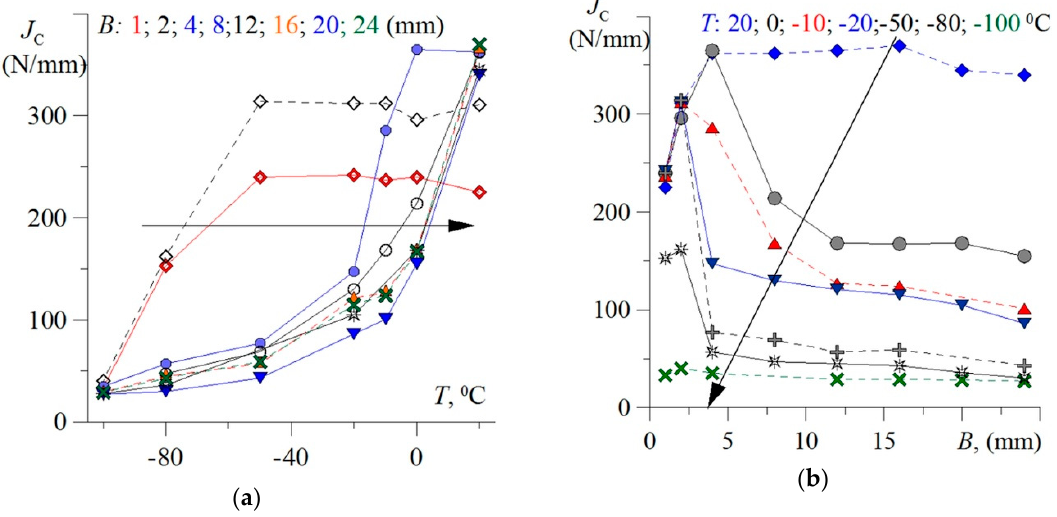
Figure 5. The critical values J C with temperature changes for ( a ) specimens of 2 mm and ( b ) 12 mm thickness.